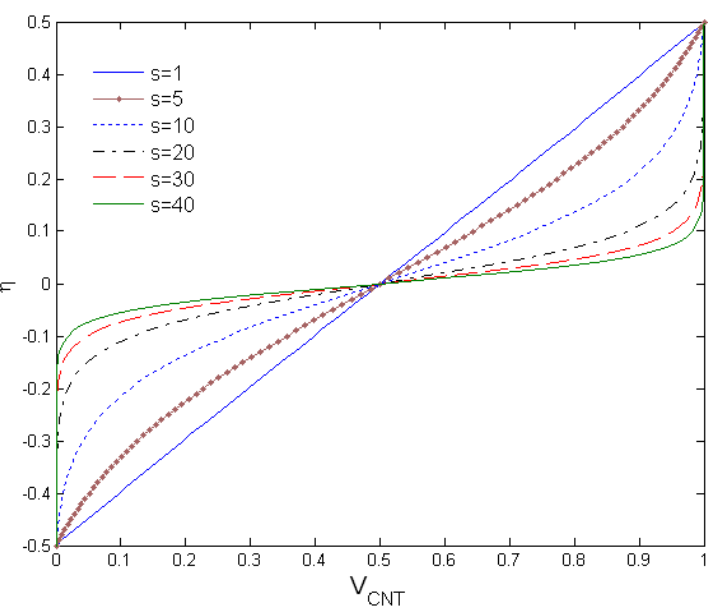
V through the thickness for di ff erent exponents s . CNT